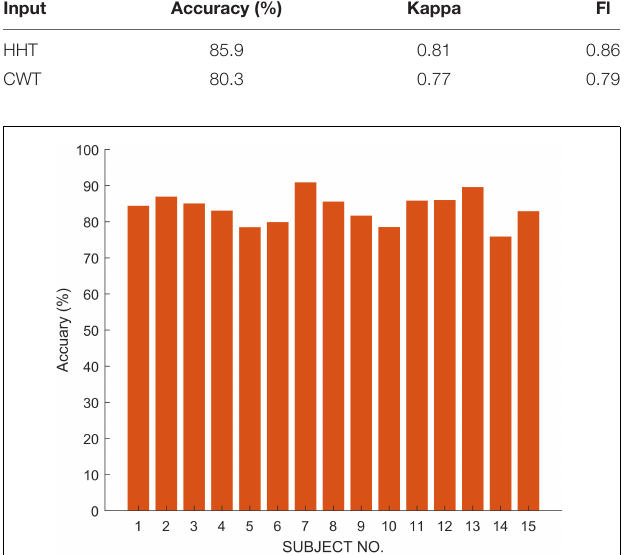
FIGURE 6 | The accuracy of classification experiments based on Private Data.